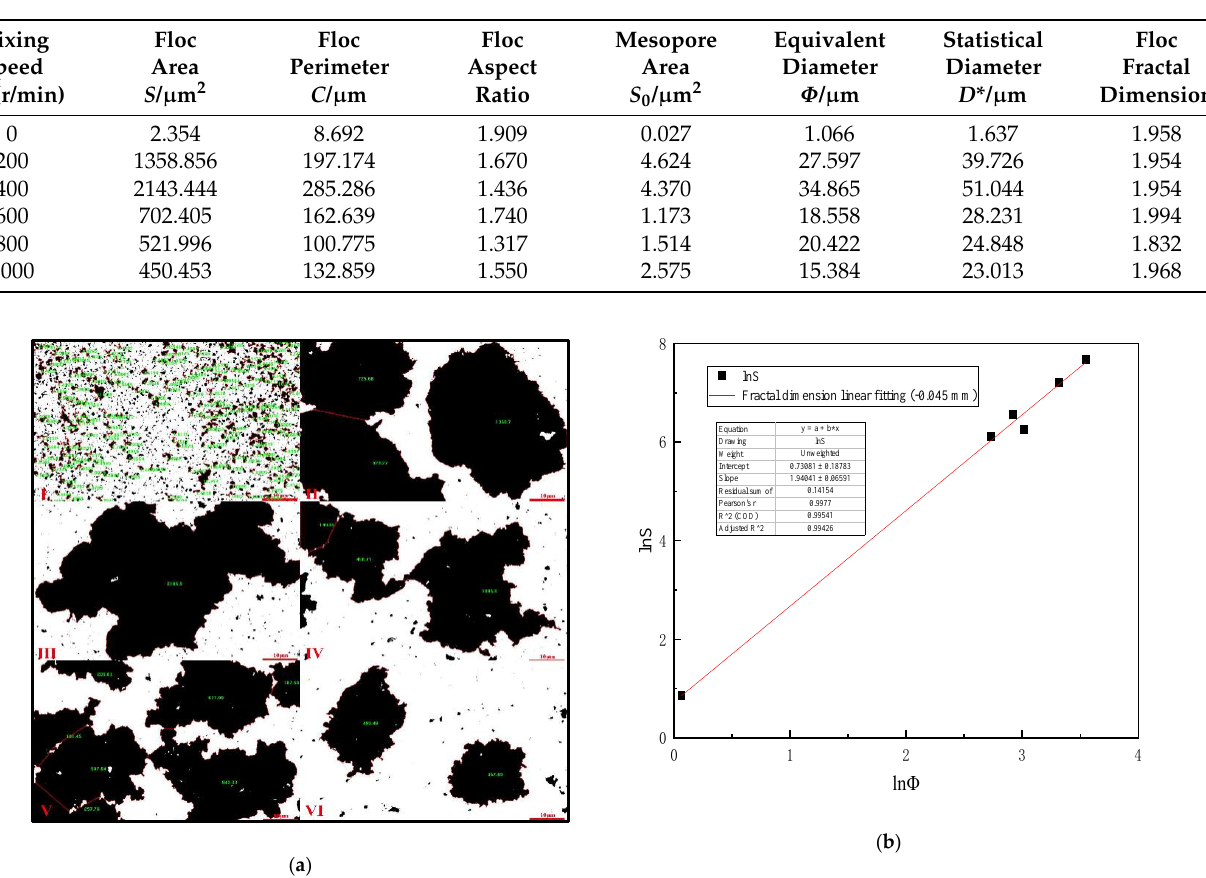
Figure 11. ( a ) Area diagram of − 0.045 mm coal slime floc at different mixing speeds. ( I ) 0, ( II ) 200 r/min, ( III ) 400 r/min, ( IV ) 600 r/min, ( V ) 800 r/min, ( VI ) 1000 r/min; ( b ) Fractal dimension fitting diagram of settling floc of − 0.045 mm coal slime.